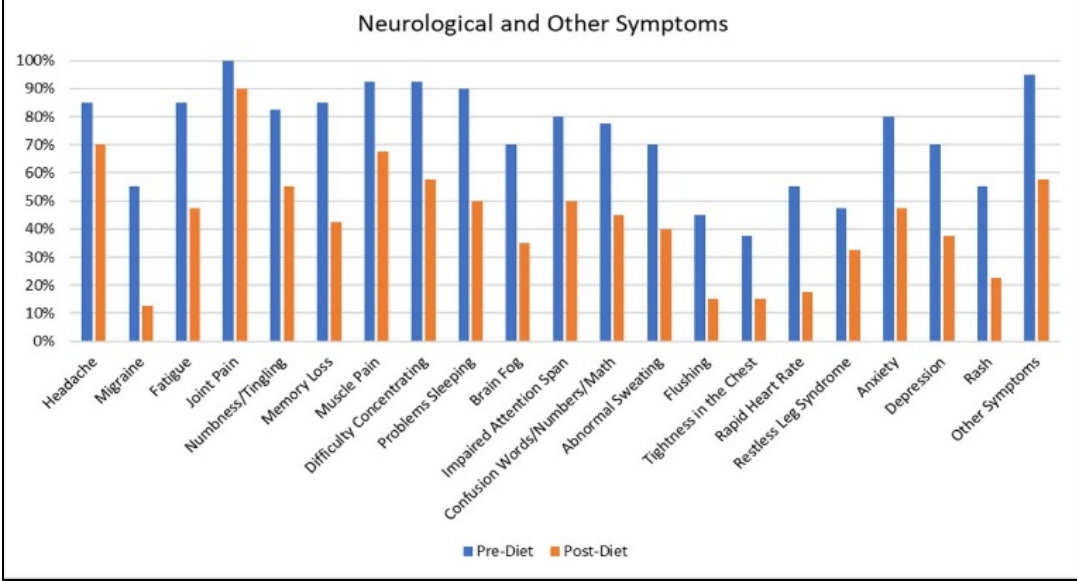
Figure 3. The percentage of veterans reporting neurological and other symptoms pre–post diet.